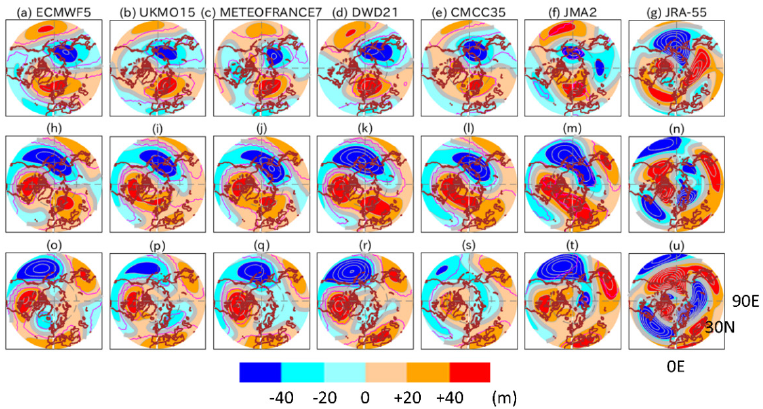
Bottom panels ( o – u ) plot differences of the EL MSSWs from the LA MSSWs. Magenta contours denote statistically significant anomalies or differences at the 95% level. denote statistically significant anomalies or differences at the 95%